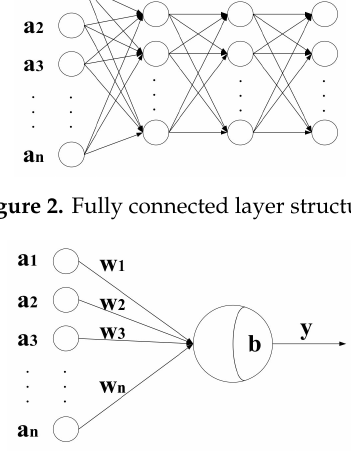
Figure 3. M-P neuron